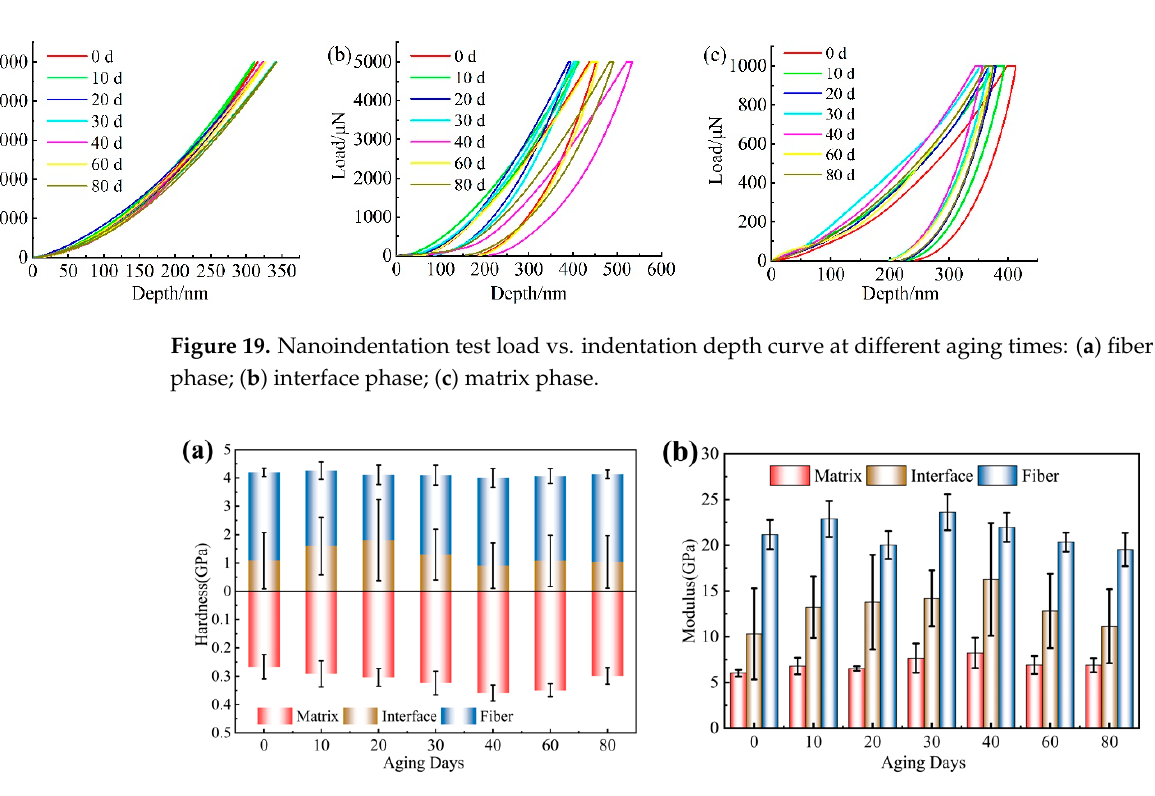
Figure 20. ( a ) Relationship between hardness and aging time for each component; ( b ) relationship between the modulus of each component and aging time.